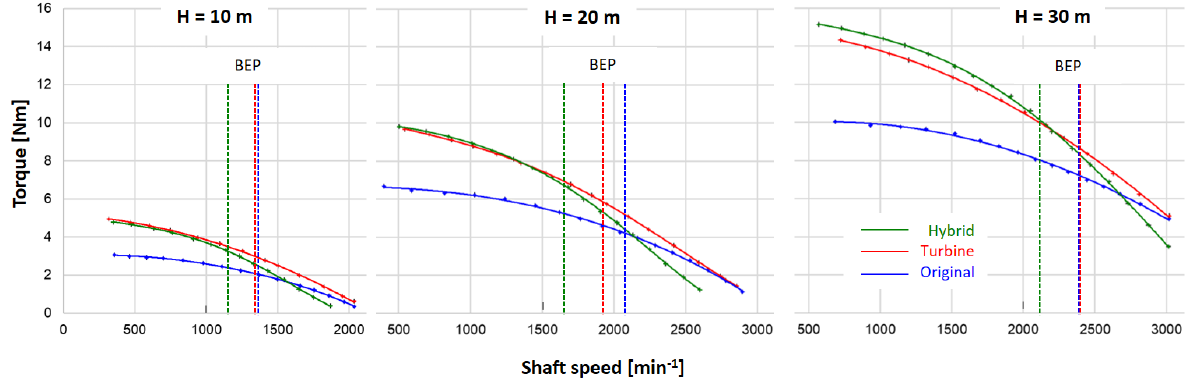
Figure 10. Torque in terms of dependence on shaft speed.